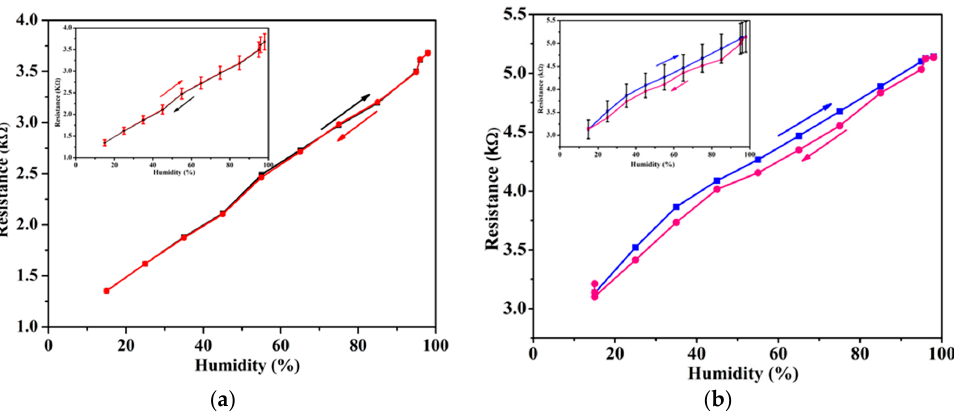
Figure 2. ( a ) Plot of the humidity response of the suspended CNTs, and ( b ) Plot of the humidity response of the non-suspended CNTs. The hysteresis characteristic is also shown. The insets in each figure show the average hysteresis profile of 6 identical devices measured under similar testing conditions.